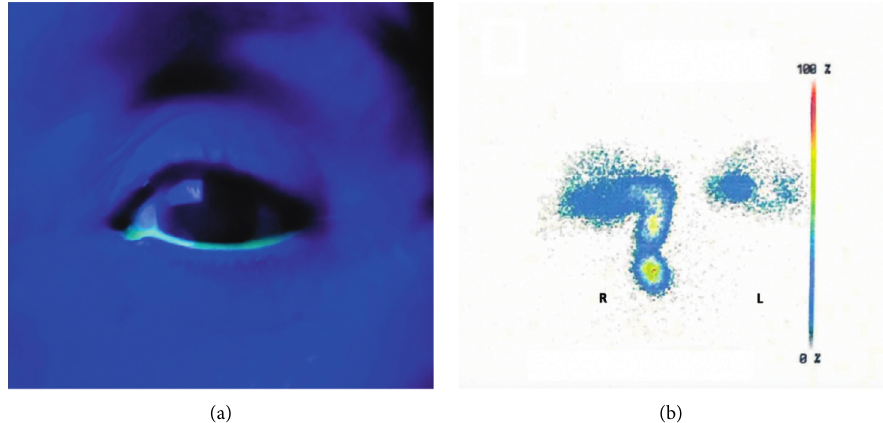
Figure 1: Delay of lacrimal transit on the left eye after 5 minutes demonstrated with fluorescein dye disappearance test (FDDT) (a) and dacryoscintigraphy (b).